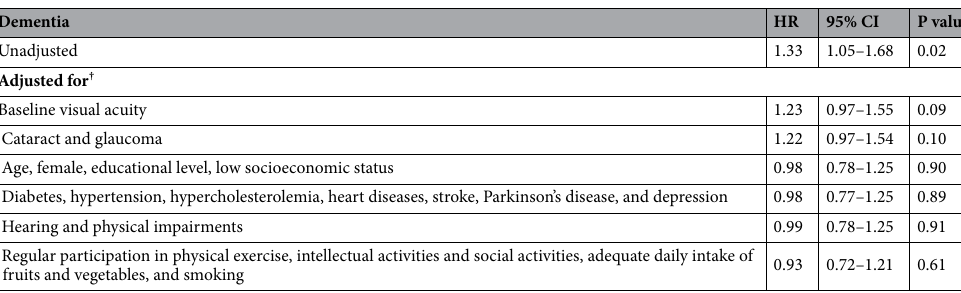
Table 2. Hazard ratios (HRs) of baseline dementia for incident visual impairment over 6 years. †Models were adjusted for baseline visual acuity and additionally for each of the following groups of